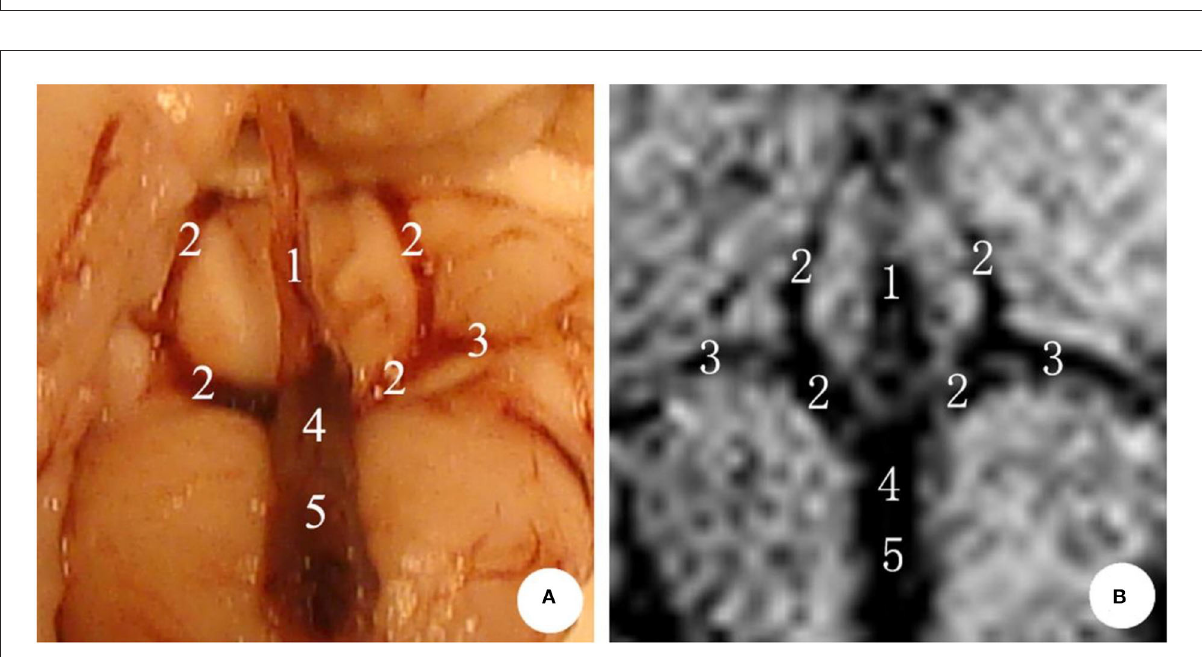
FIGURE2 The deep cerebral veins in rabbit brain. (A) Microscopic anatomy; (B) MIP image in MRI. 1: inferior sagittal sinus; 2: internal cerebral vein; 3: basal vein; 4: great cerebral vein; 5: straight sinus.